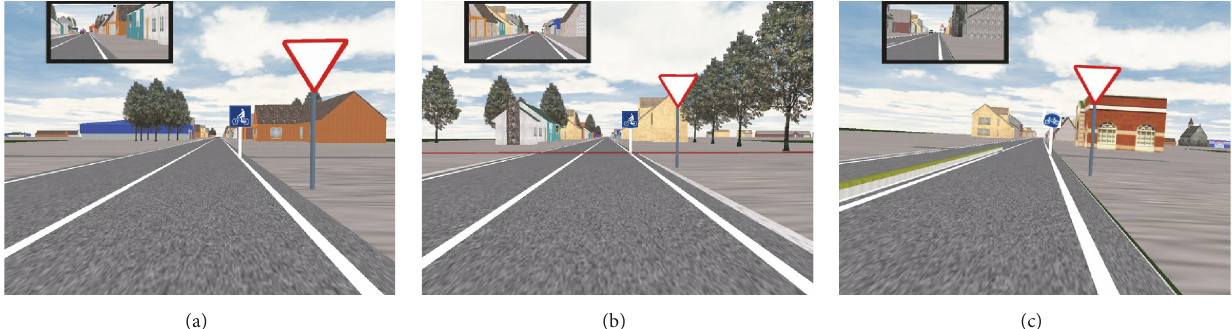
Figure 2: Bicycle crossroads as seen by drivers during the experiment: (a) baseline condition; (b) colored paved markings; (c) raised island.